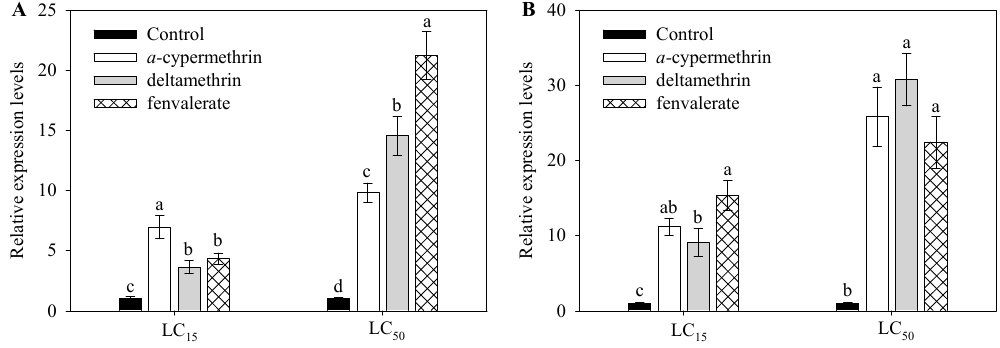
Figure 3. Effects of α -cypermethrin, deltamethrin or fenvalerate on CYP9A105 expression in midguts ( A ) and fat body ( B ) Spodoptera exigua . Insects were treated with insecticides at LC 15 doses ( α -cypermethrin, deltamethrin and fenvalerate at 0.10, 0.20 and 5.00 mg/L, respectively) and LC 50 doses ( α -cypermethrin, deltamethrin and fenvalerate at 0.25, 0.40 and 10.00 mg/L, respectively), for comparison with control treatments. RT-qPCR analysis was used to determine relative transcript levels. Data shown are mean ± SE derived from three biological replicates. Different letters above bars indicate significant differences ( p < 0.05) according to the Duncan’s multiple range test.